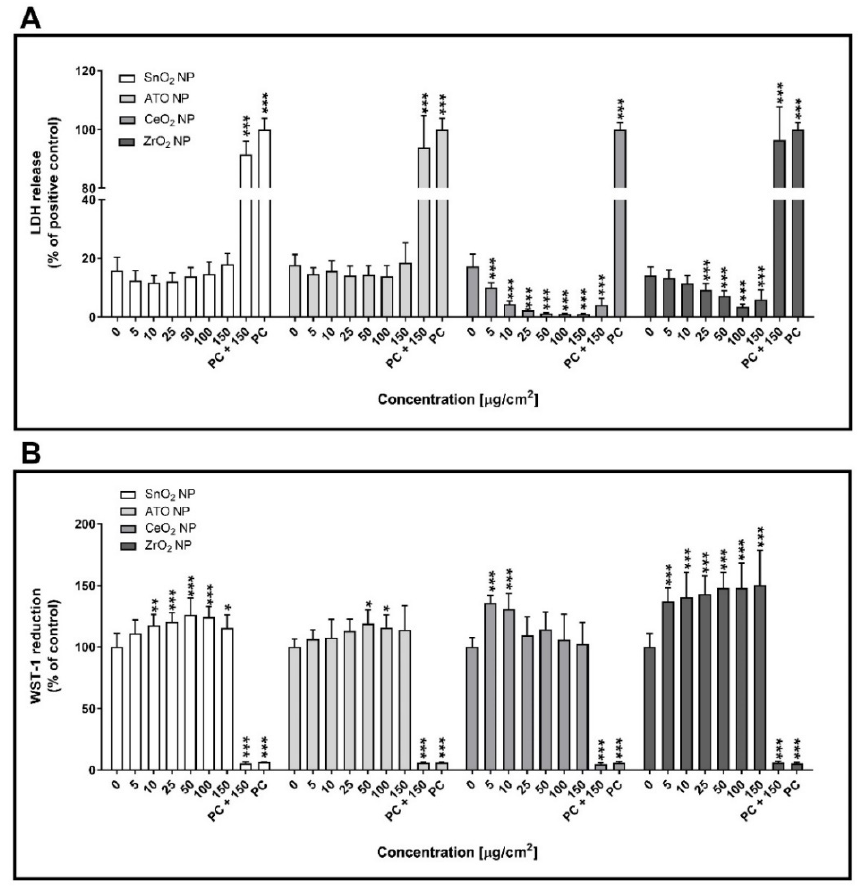
Figure 4. Cytotoxicity of the tested engineered nanoparticles (ENP) (SnO 2 , ATO, CeO 2 and ZrO 2 ) in human alveolar epithelial cells under submerged conditions being exposed for 24 h. Lactate dehydrogenase release (LDH) release ( A ) and WST-1 reduction ( B ) assays were carried out after 24 h exposure to the NP suspensions prepared in serum-free cell culture medium. Data are expressed as mean ± standard deviation ( n = 3–4). LDH release values were normalised considering the positive control (total LDH release; cells lysed with 2% Triton X-100), while WST-1 reduction values were normalised considering the negative control. Data was analysed by the one-way analysis of variance (ANOVA) test followed by the Dunnett’s post hoc test for multiple comparisons. * p ≤ 0.05, ** p ≤ 0.01 and *** p ≤ 0.001 vs. negative control. PC: Positive control. Figure 5 refers to the cytotoxicity of the aerosolised ATO, CeO 2 and ZrO 2 NP in hu- man alveolar epithelial cells at ALI. As expected, before exposure, no effects on the LDH release were observed in control, an indicator of cell health (data not shown). Immediately